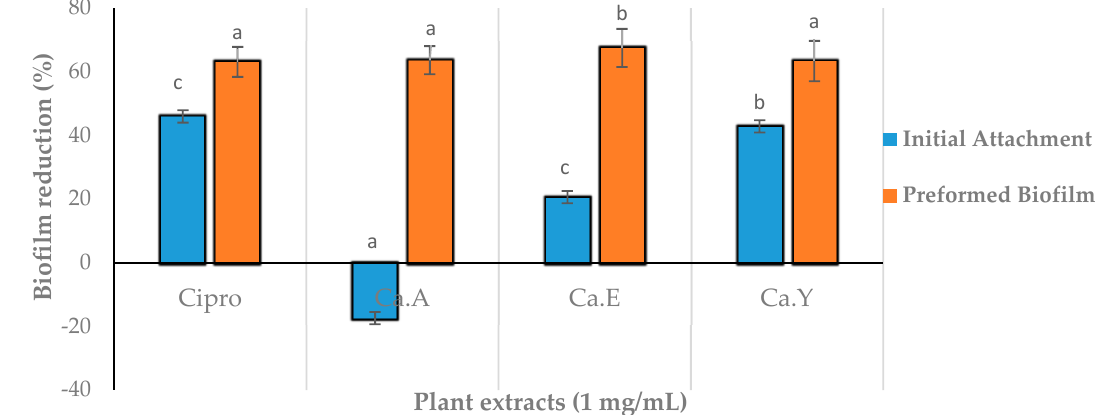
Figure 6. Antibiofilm activities of Calpurnia aurea extracts at 1 mg / mL against Pseudomonas aeruginosa . Ca.A—Acetone, Ca.E—Ethanol, and Ca.Y—Ethyl acetate extract. Data presented as mean ± standard deviation of three replicates, n = 3. Di ff erent letters represent statistical di ff erences at p -value = 0.05 (GLM and LSD).